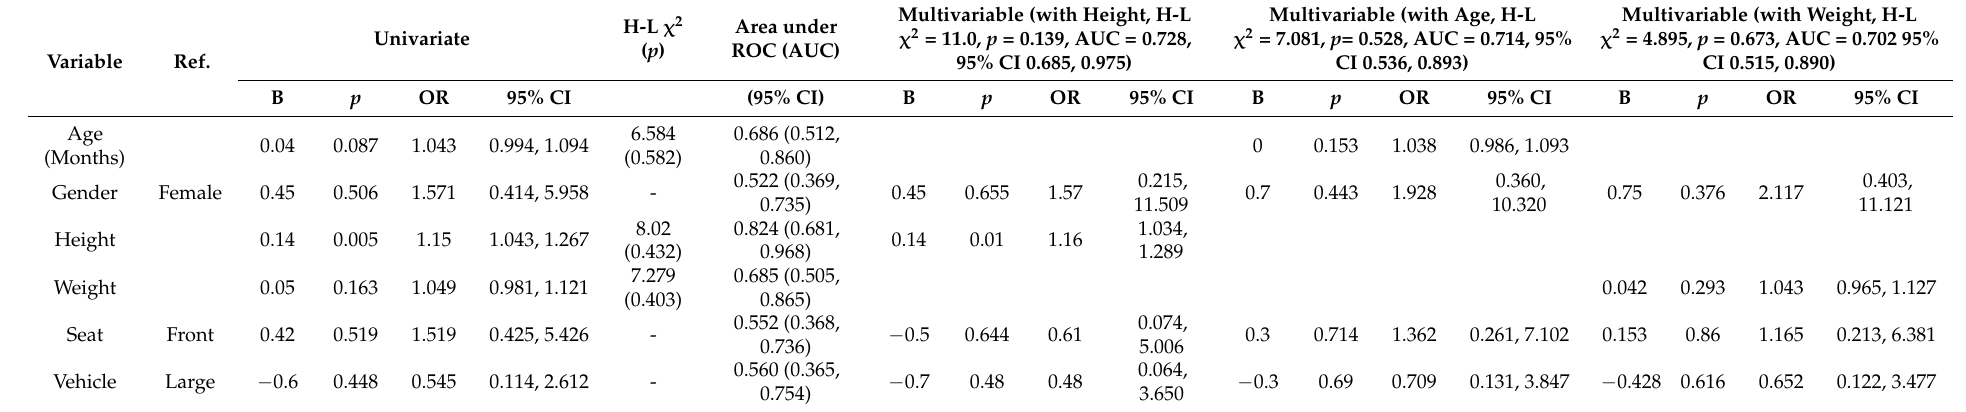
Table 1. Regression results for sash belt fit.